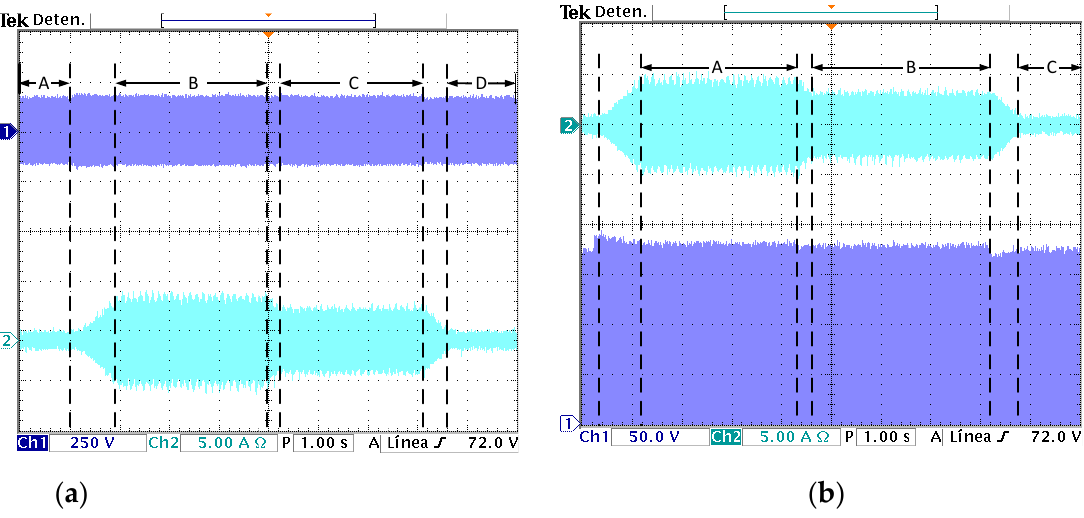
Figure 14. Node voltage variations with the proposed system turned on. A: V N = 120 V RMS , B: V N = 124.6 V RMS , C: V N = 124.6 V RMS and D: V N = 120 V RMS . ( a ) original waveform and ( b ) magnified waveforms.